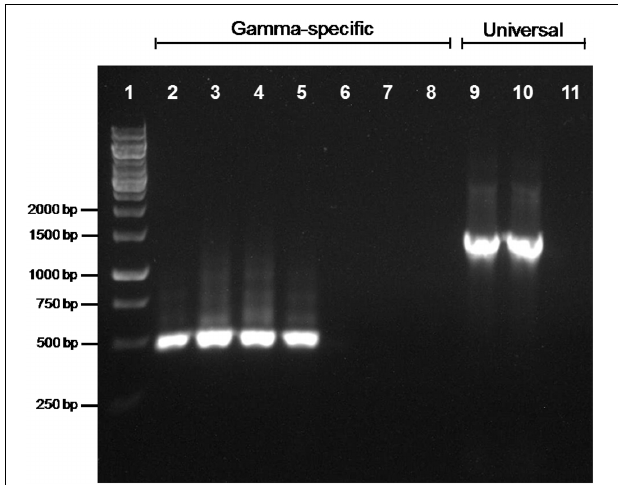
FIGURE 3 | PCR screening for gammaproteobacterial endosymbionts. Gammaproteobacterial-specific primers were used on T DNA from P. citri (lane 2), D. boninsis (lane 3), P. viburni (lane 4), P. longispinus (lane 5), P. peruvianus (lane 6), and P. madeirensis (lane 7). The quality of samples from P. peruvianus and P. madeirensis was tested using 16S rDNA universal primers (lanes 9 and 10, respectively). Lanes 8 and 11 are the results of negative controls for each pair of